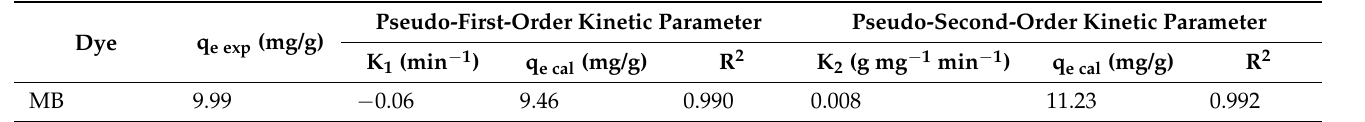
Table 1. Calculated parameters of the pseudo-first-order and pseudo-second-order kinetic models for adsorption of MB-dye over GO@CS composite beads.